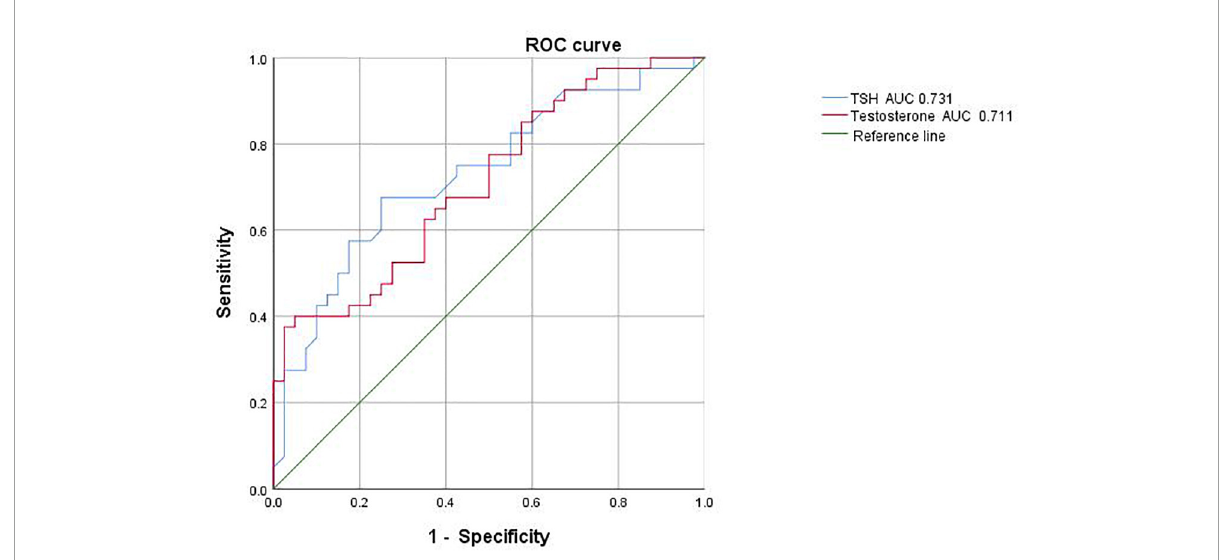
FIGURE2 Receiver operating characteristic (ROC) curve analysis of male adolescent depressed patients with non-suicidal self-injury